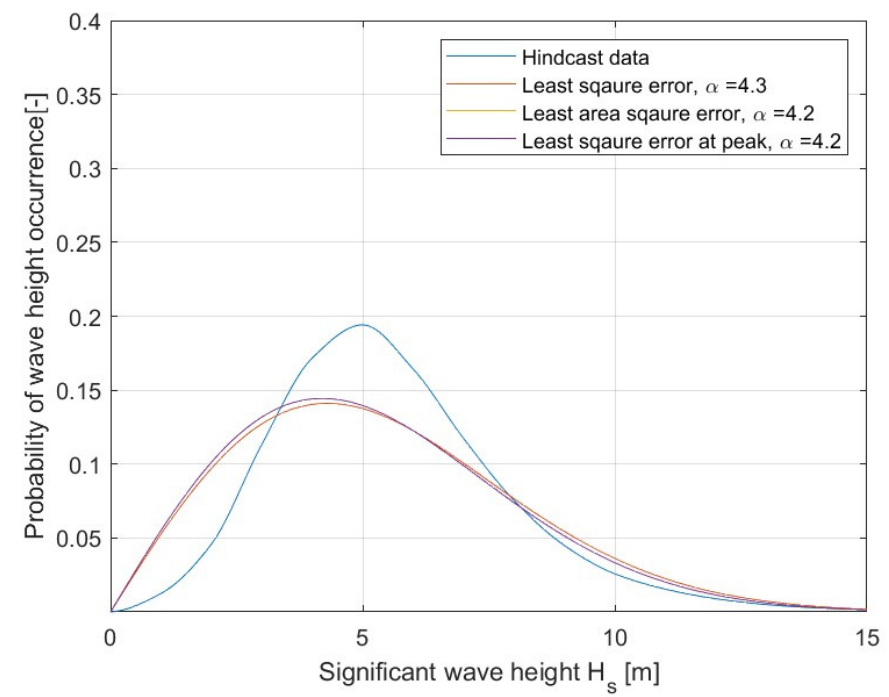
Figure 10. Plots of WST mean sea pdf (sea area 9—season 4).